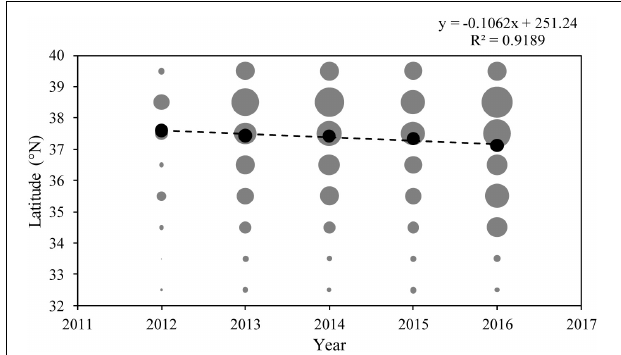
FIGURE 5 | Inter-annual and latitudinal trends of fishing intensity (represented by sum of log 10 transformed fishing hours) in the Yellow Sea. Gray dots represent total fishing hours of each latitudinal category in each year, black dots represent the centroid of total fishing hours in each year, and linear regression was given based on gravity